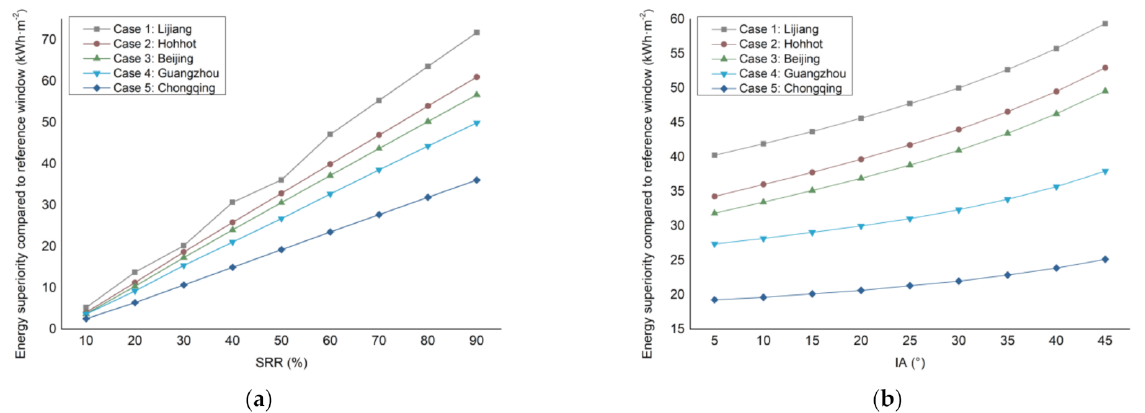
Figure 7. Energy superiority compared to reference window: ( a ) Flat roof; ( b ) Sloped